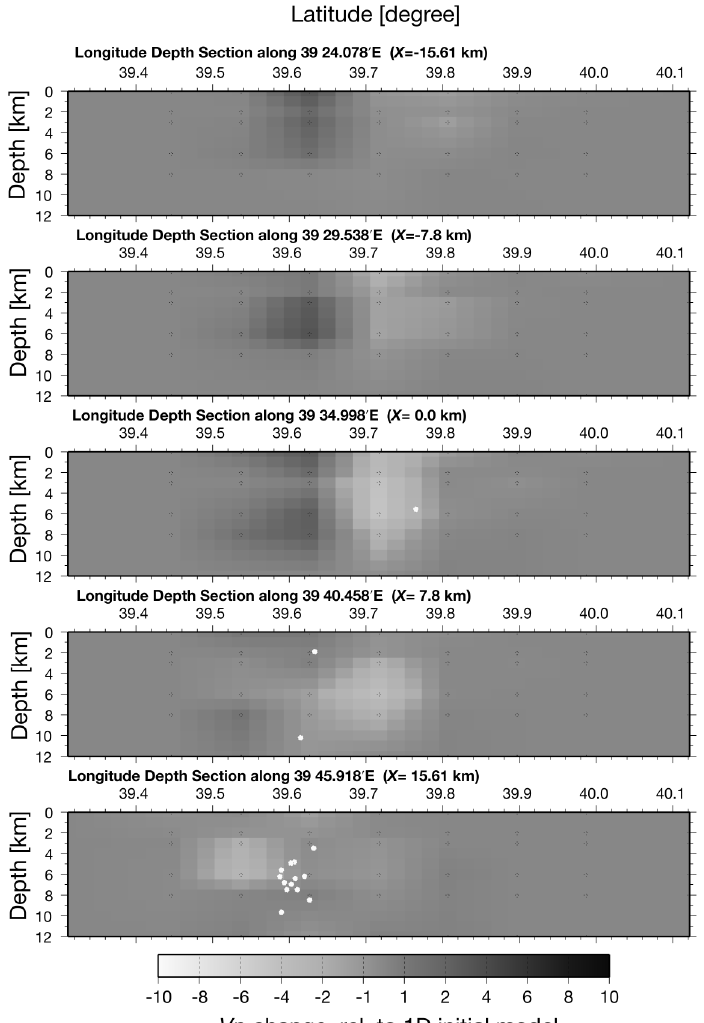
Fig. 5. W-E vertical depth sections of the percentage P -wave velocity change along profiles of the constant lat- itudes selected at equal degrees for the model. The constant latitudes values are shown at the top of each